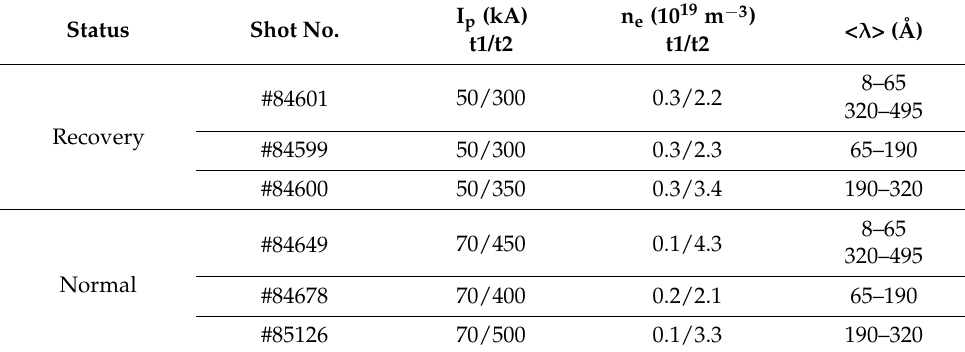
Table 1. Plasma parameters at initial phase (t1 = 0.08 s) and current platform (t2 = 5.0 s) and wavelength interval of the spectrometers in recovery and normal